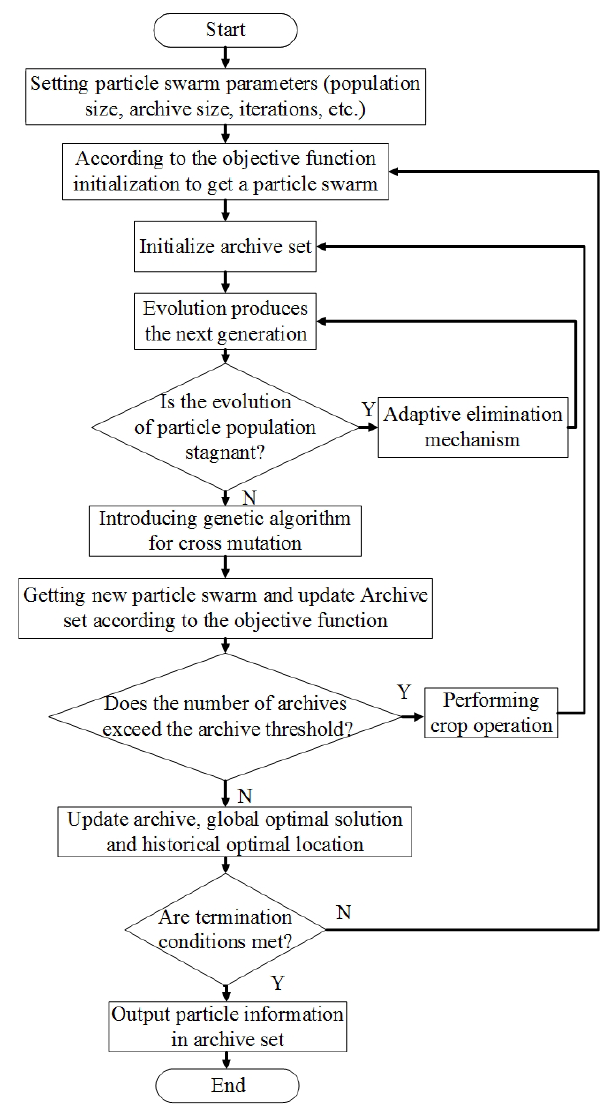
Figure 5. Flow chart of the improved particle swarm optimization algorithm.